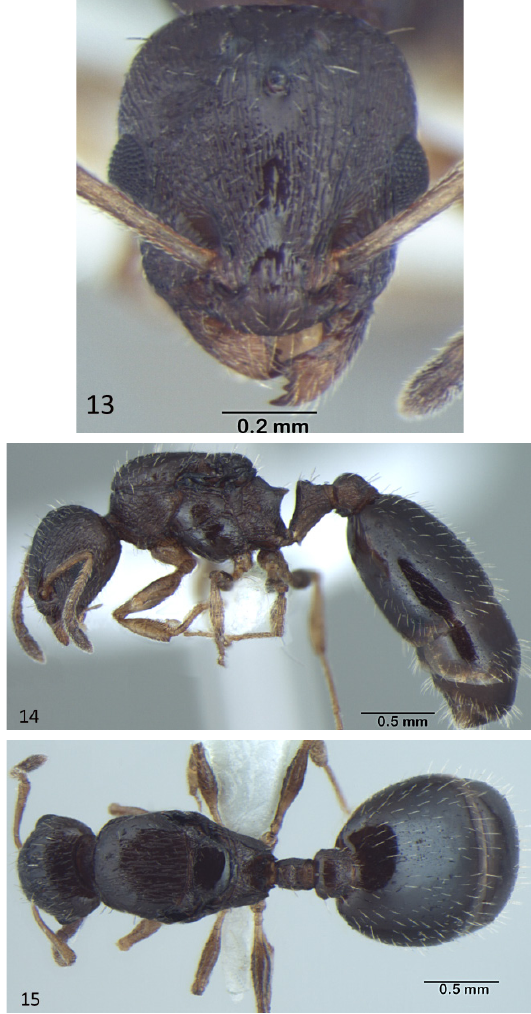
Figs 13-15 . Queen Temnothorax rothneyi (Forel, 1902): 13-Head, full face view; 14- Body, lateral view; 15- Body, dorsal view.